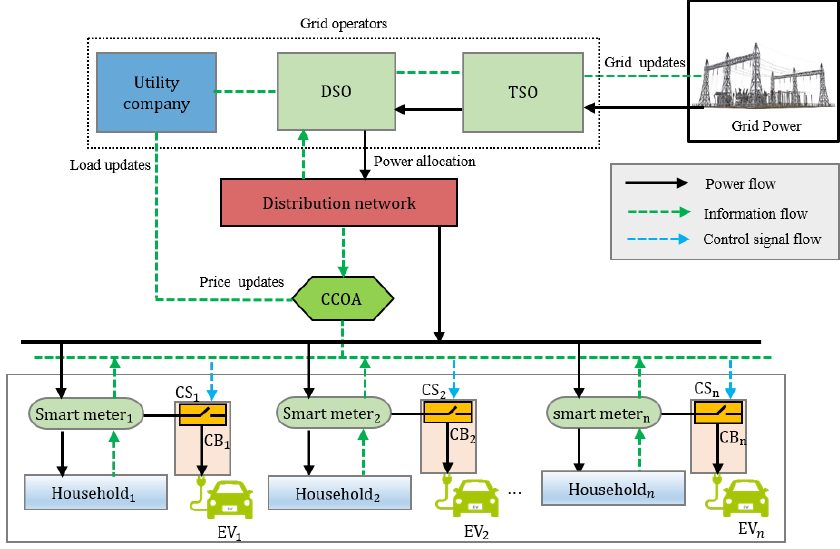
Figure 3. System model of the proposed charging cost optimization algorithm